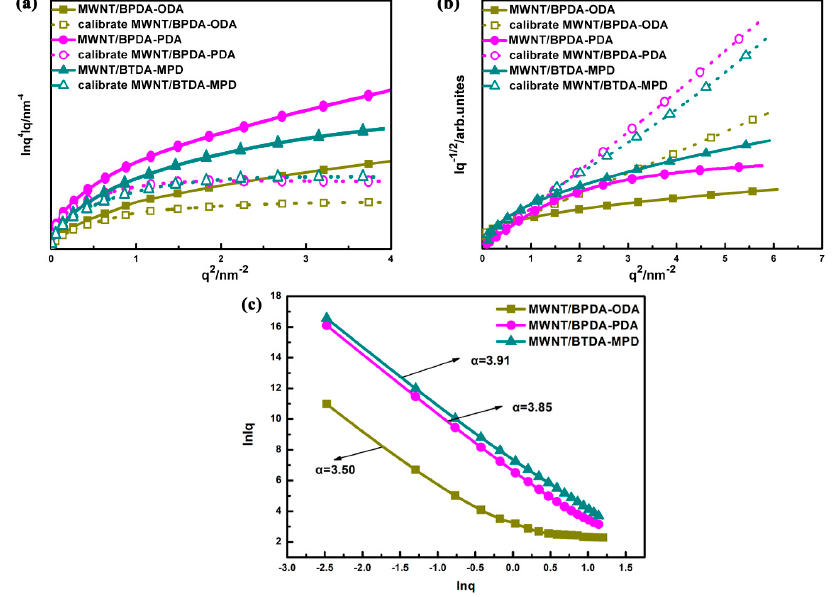
Figure 3. The small-angle X-ray scattering (SAXS) curves of ( a ) BPDA-ODA, ( b ) BPDA-PDA, and ( c ) BTDA-MPD. SAXS intensity as a function of scattering vector for ( d ) aligned carbon nanotube / polyimide composites and ( e ) PIs and MWNTs.